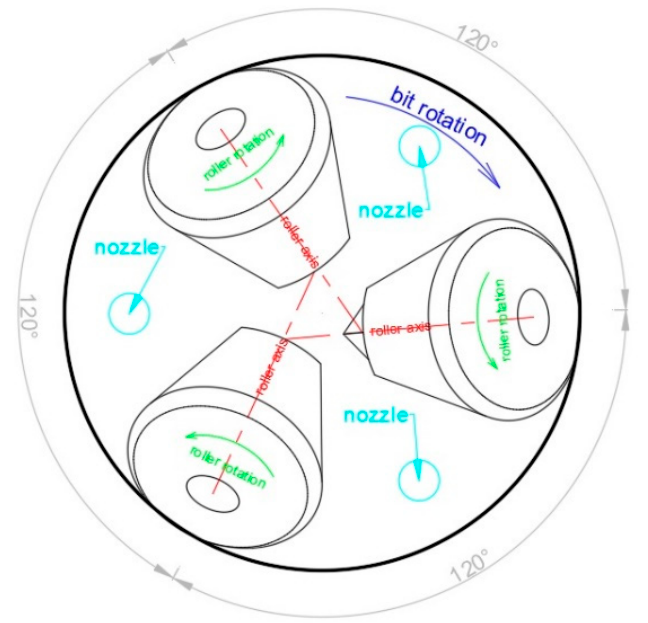
Figure 1. Settings of rollers for soft rock formations roller cone drill bits.